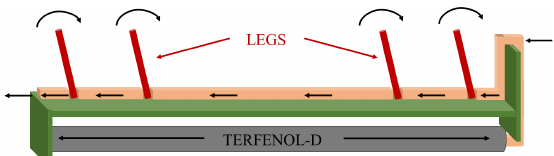
Figure 8. Sketch of the leg structures for the macro model of the micro mobile robot developed in